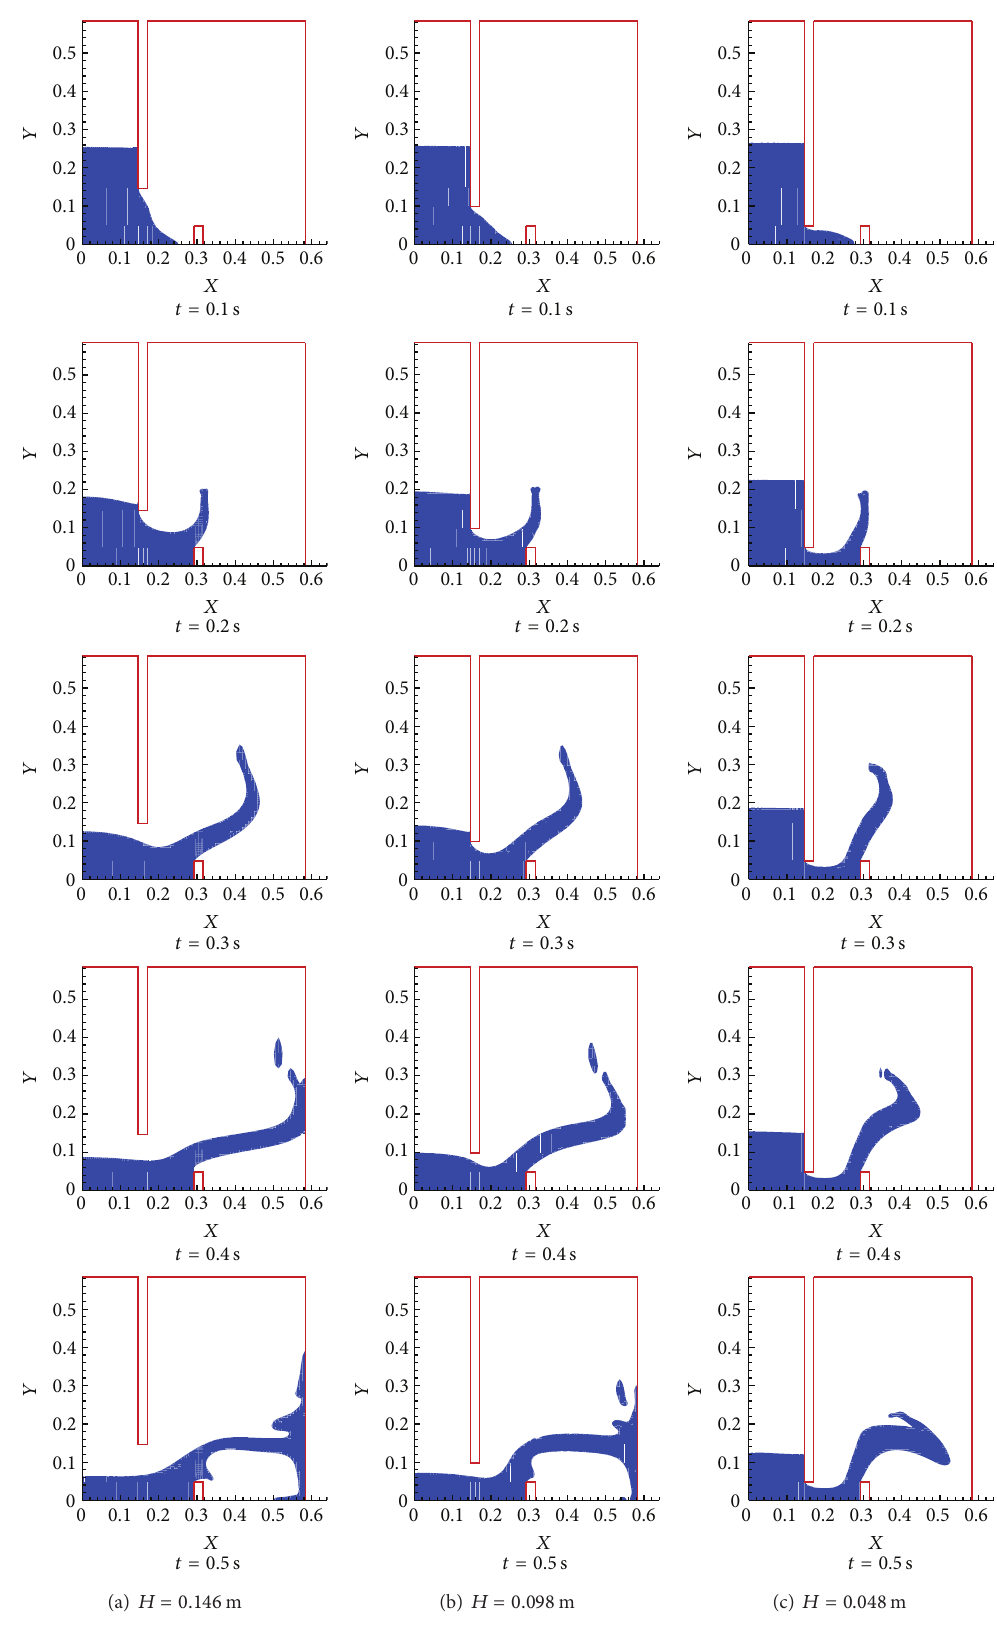
Figure 11: Water evolution with a